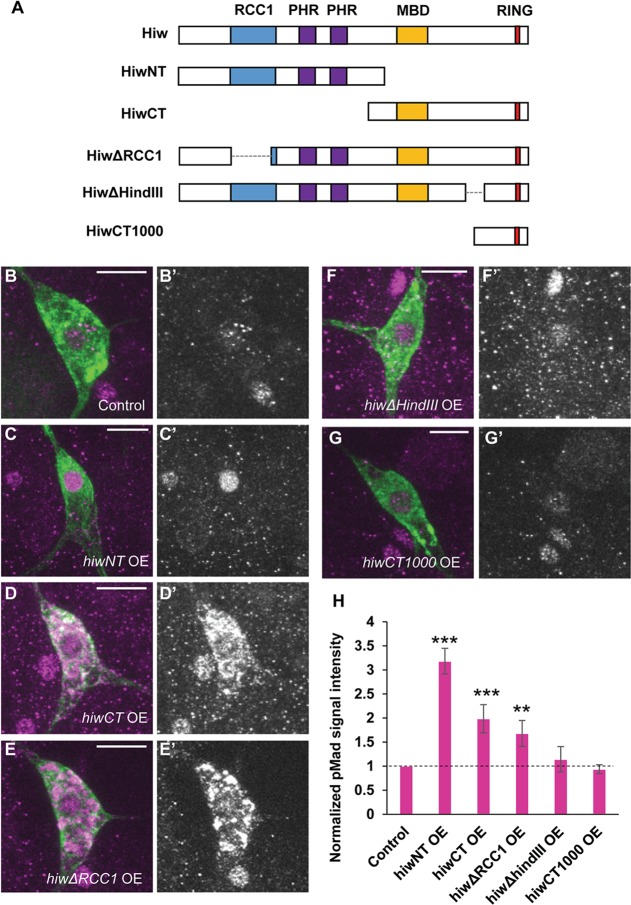
pMad signals in nociceptors expressing various hiw deletion constructs.(A) A schematic showing the structure of Hiw and Hiw deletion constructs. (B-G) Representative images of pMad immunoreactivity in nociceptor cell bodies. Green represents mCD8::GFP and magenta shows pMad signals. (B’-G’) Split images for pMad signals. Scale bars represent 10 μm. (H) Quantification of nuclear pMad signals in nociceptors. Nociceptors expressing hiwNT OE (ppk-GAL4 UAS-mCD8::GFP x UAS-hiwNT, n = 12), hiwCT OE (ppk-GAL4 UAS-mCD8::GFP x UAS-hiwCT, n = 12) and hiwΔRCC1 OE　(ppk-GAL4 UAS-mCD8::GFP x UAS-hiwΔRCC1, n = 12) showed nuclear pMad signals increased by 218 ± 26%, 99 ± 19% and 68 ± 18%, respectively. A significant difference in nuclear pMad level compared to controls was not detected in hiwΔHindIII OE (ppk-GAL4 UAS-mCD8::GFP x UAS-hiwΔHindIII, n = 12) or hiwCT1000 OE (ppk-GAL4 UAS-mCD8::GFP x UAS-hiwCT1000, n = 12). Control (ppk-GAL4 UAS-mCD8::GFP/+, n = 12) ** p < 0.01, *** p < 0.001 (Mann-Whitney’s U-test). Error bars represent standard error.